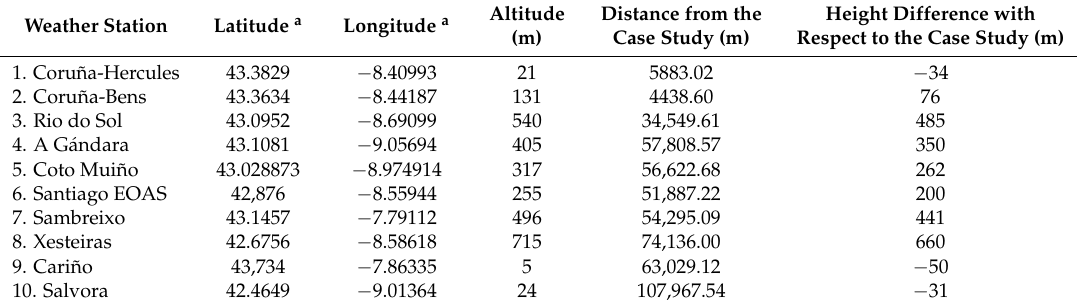
Table 3. Coordinates of the weather stations.